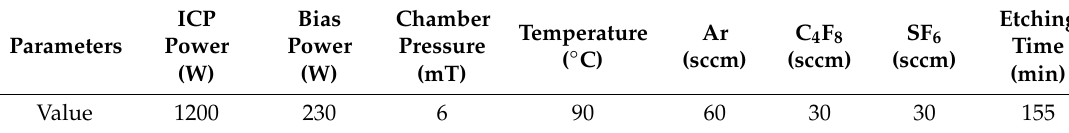
Table 2. The parameters of optimized etching process.